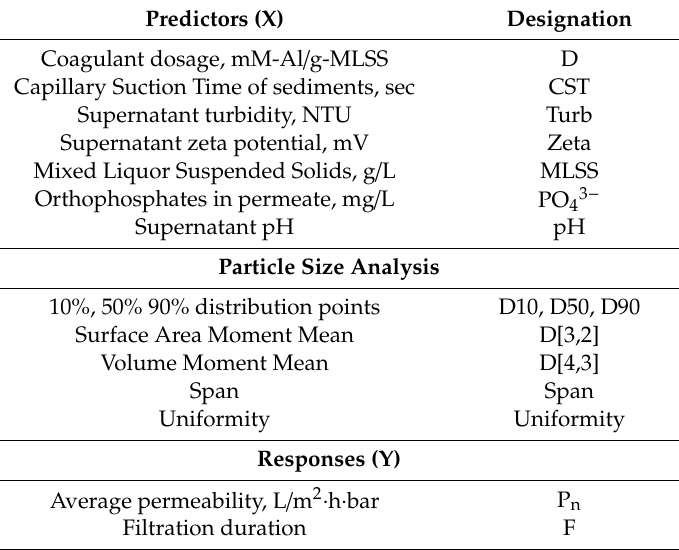
Table 2. Partial Least Squares regression